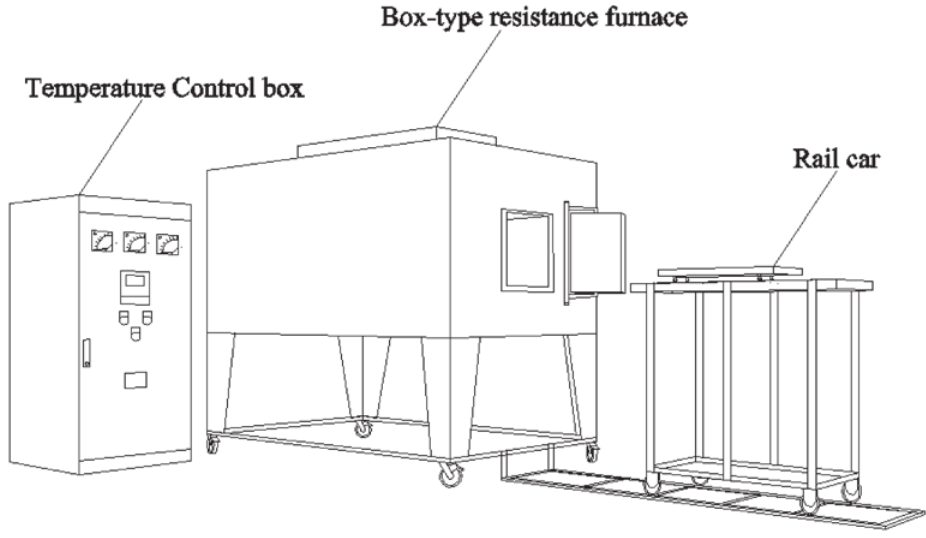
Fig. 2: RX3-20-12 box-type resistance